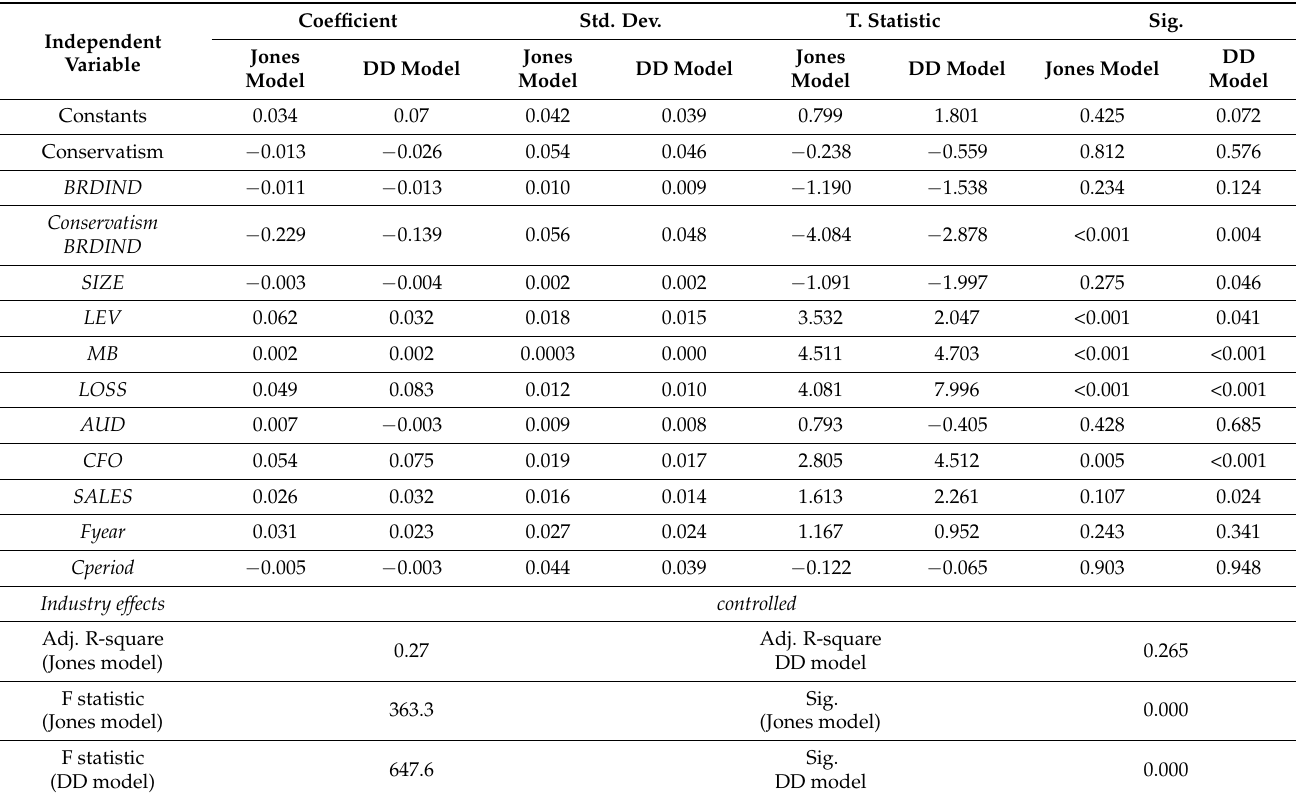
Table 4. The results of the third hypothesis